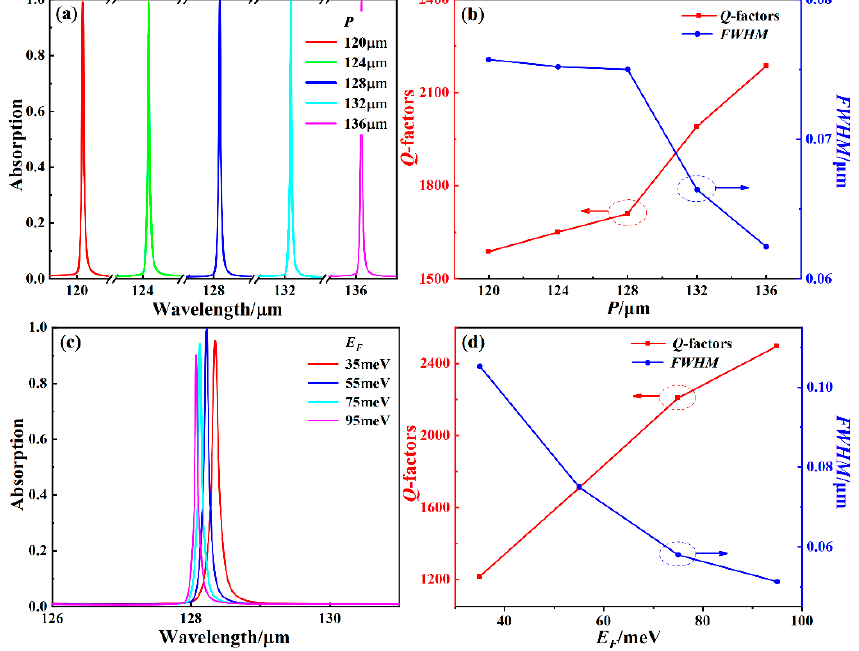
Figure 5. Absorption spectra at different periods P ( a ) and Fermi energy E F ( c ), respectively. Q -factor and FWHM of the absorption spectra with varying periods P ( b ) and Fermi energy E F ( d ), respectively.